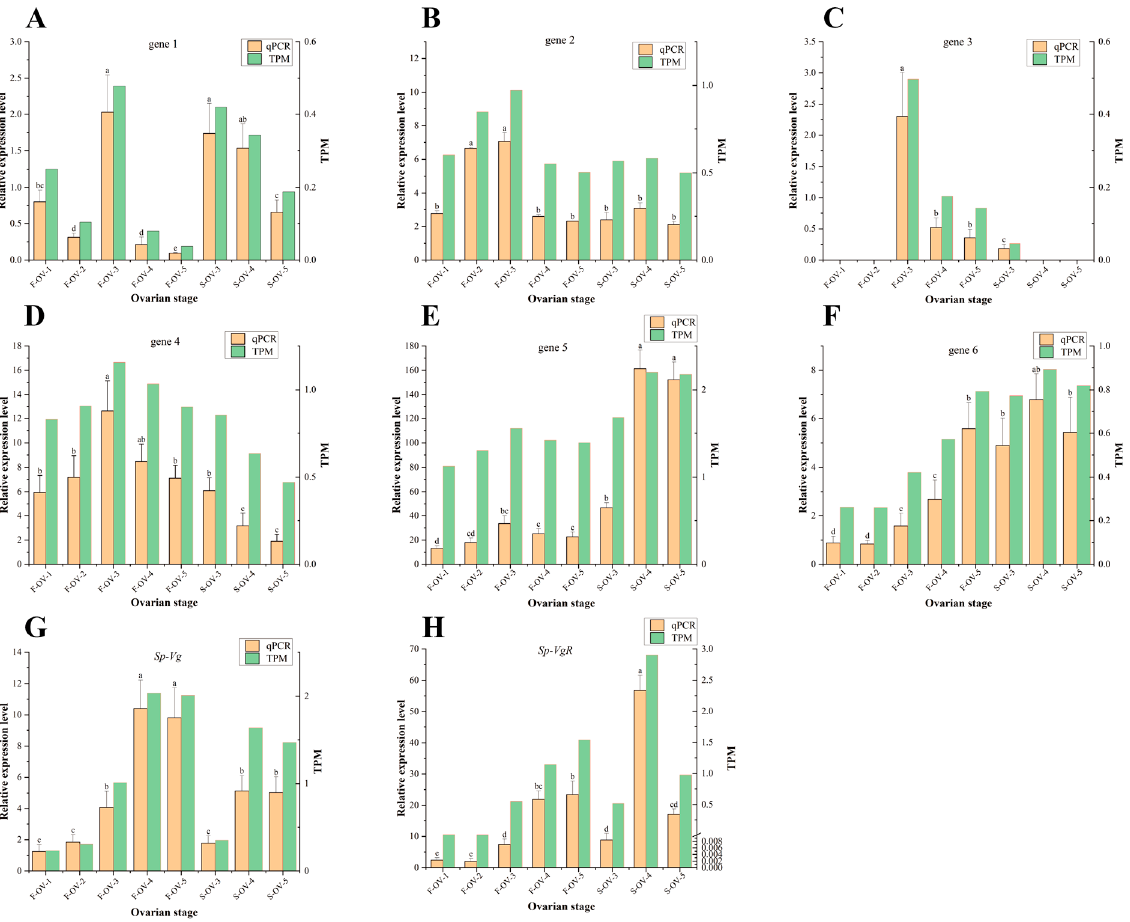
Figure 3. qRT-PCR validation of the DEGs from the transcriptome sequencing. The sample information represented by abscissa (see Table 1) and the ordinate represents the gene relative expression level of qRT-PCR and transcriptome sequencing (TPM). A total of 6 genes were validated ( A ) gene 1, ( B ) gene 2, ( C ) gene 3, ( D ) gene 4, ( E ) gene 5, ( F ) gene 6, ( G ) Sp-Vg , and ( H ) Sp-VgR . All the information about the genes in the qRT-PCR are listed in the Supplementary File Table S1. Different superscript letters in the column of the figures indicate a significant difference ( p <